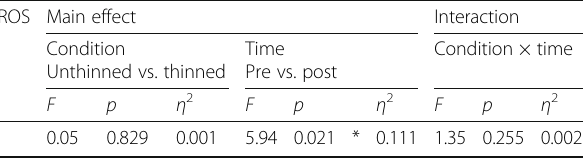
Table 11 Results of two-way repeated measures ANOVA for Re- storative Outcome Scale (subjective restorativeness) ROS Main effect Interaction Condition Time Unthinned vs. thinned Pre vs. post